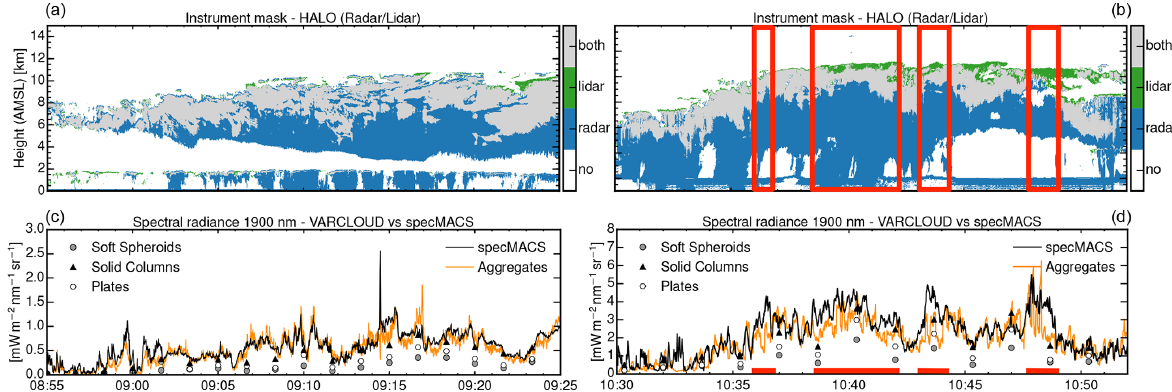
Figure 9. Radiative closure study for the measurements shown in Figs. 7 and 8. (a, b) Instrument masks indicating regions with measurements from lidar only, radar only, and both instruments. The overlap region for which radar and lidar measurements are available is much larger for the first case. (c, d) Forward-modeled solar radiances (orange lines) compare well with measured solar radiances (black lines) for the case with large instrument overlap (a) but disagree for the case with a small overlap region (b) when aggregates are used. Soft spheroids (gray circles), solid columns (black triangles), and plates (white hexagons) lead to an underestimation of reflected solar radiation in both